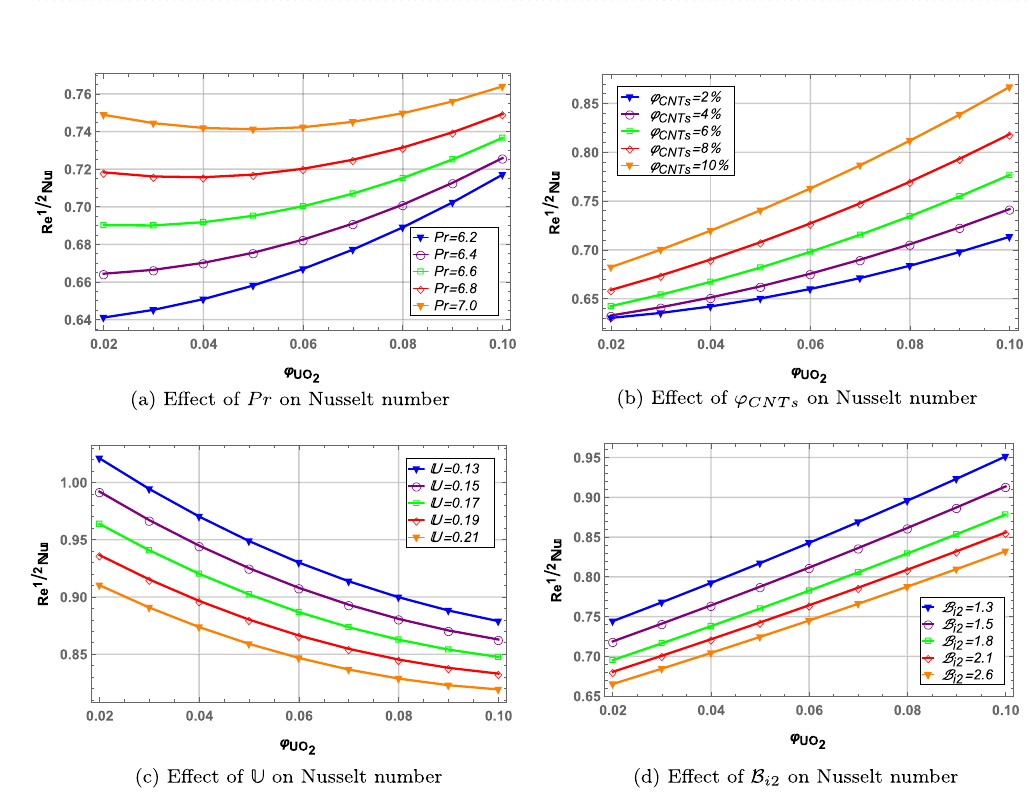
Figure 11. Heat transfer